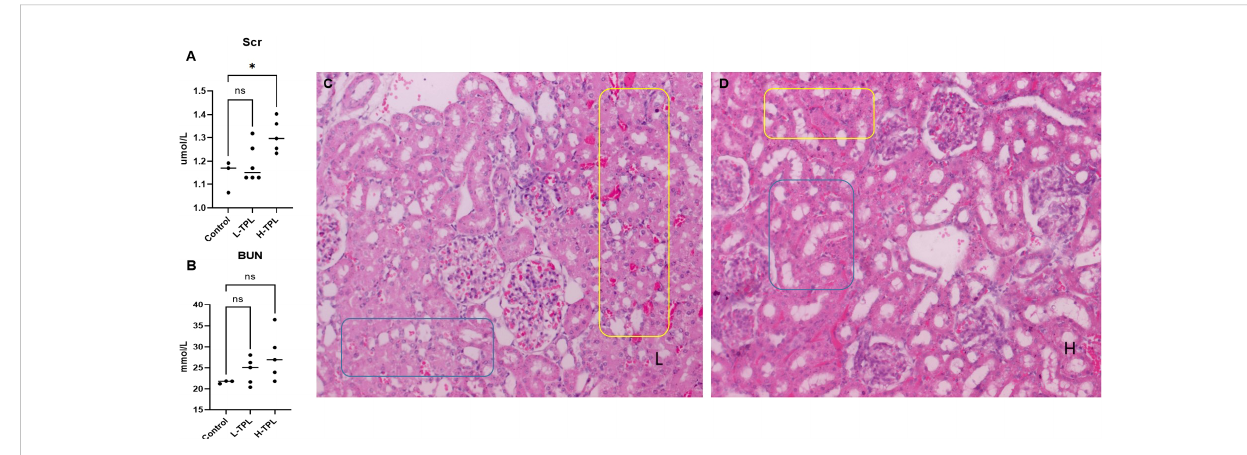
FIGURE 1 Serum creatinine (Scr), BUN and H & E staining in TPL treated rats. (A) Scr levels were signi fi cantly elevated in H-TPL groups; (B) BUN levels showed slightly but not statistically signi fi cant changes in L-TPL and H-TPL rats comparing with Ctrl group; (C, D) Representative captures of H & E staining of L-TPL (C) and H-TPL (D) kidneys, the yellow box is renal congestion and blue box is renal tubules atrophy. * indicates p < 0.05; ns indicates not signi fi